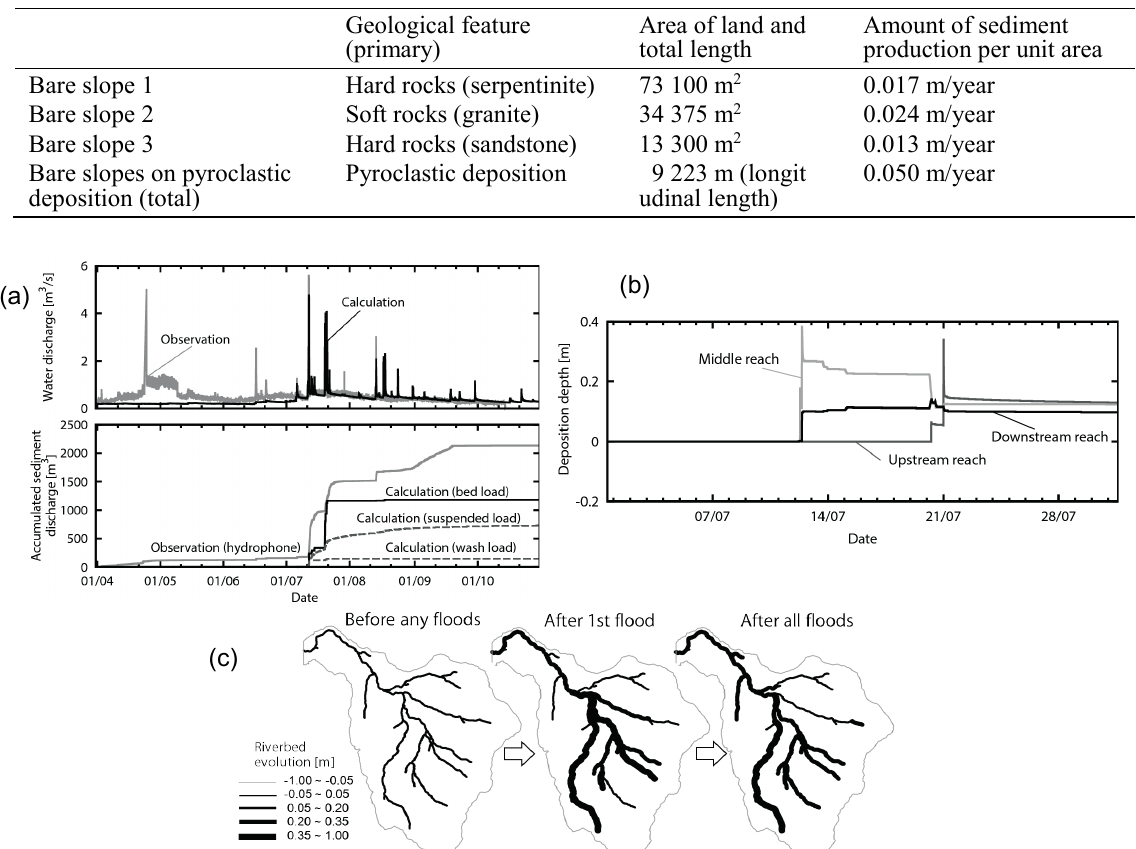
Table 1 Calculation results for sediment